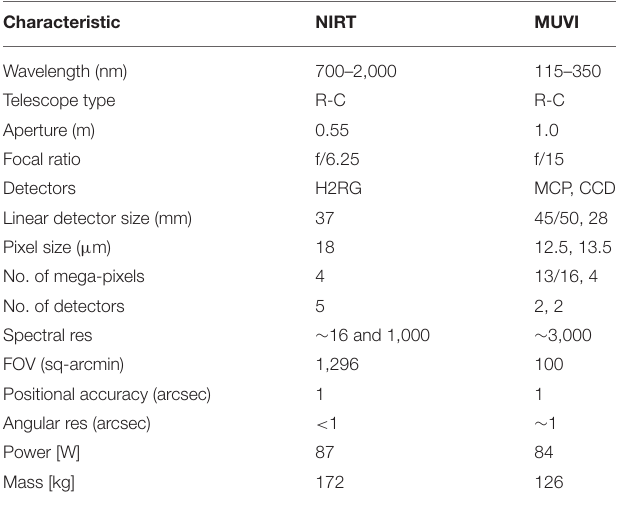
TABLE 4 | NIRT. and MUVI properties.